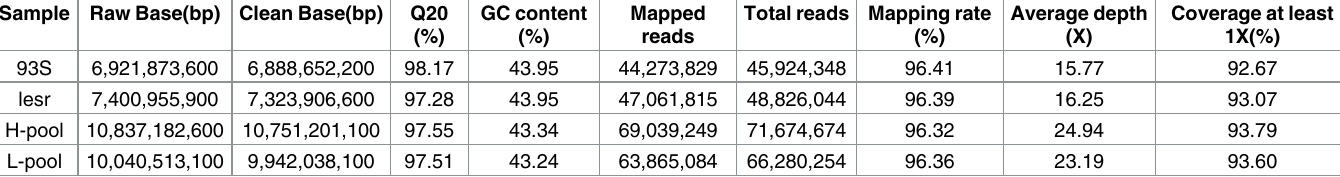
Table 2. Sequencing data quality. Sample Raw Base(bp) Clean